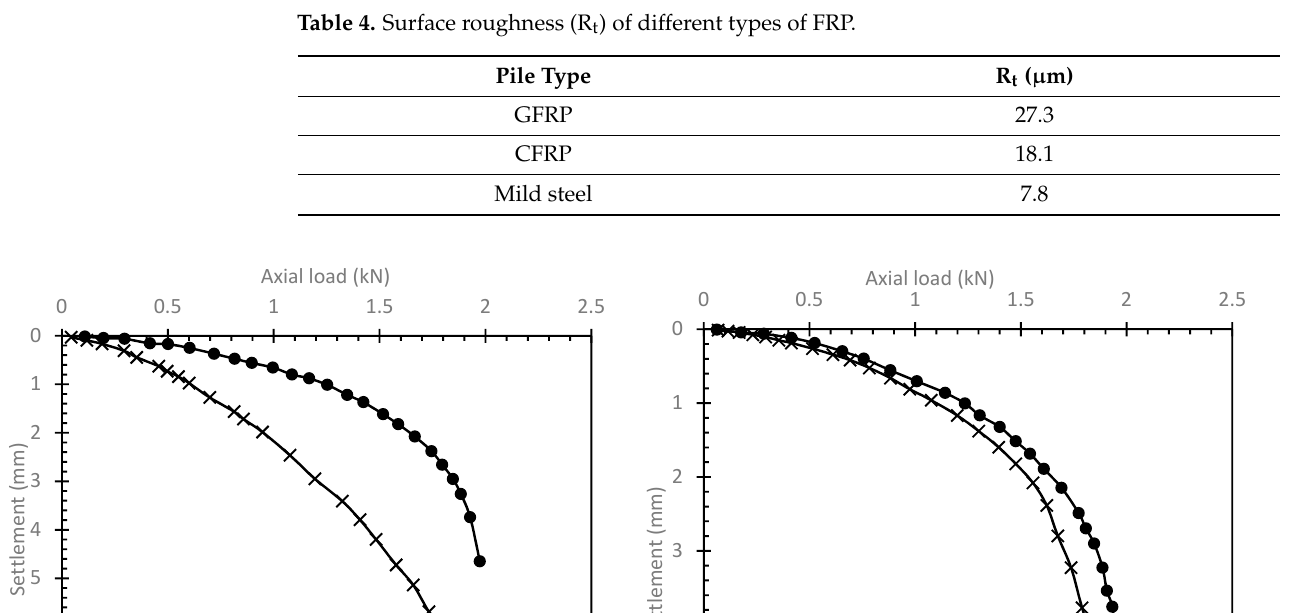
Figure 9. Effect of confined pressure on GFRP piles under an axial load ( a ) and effect of relative density on GFRP piles under an axial load ( b ).